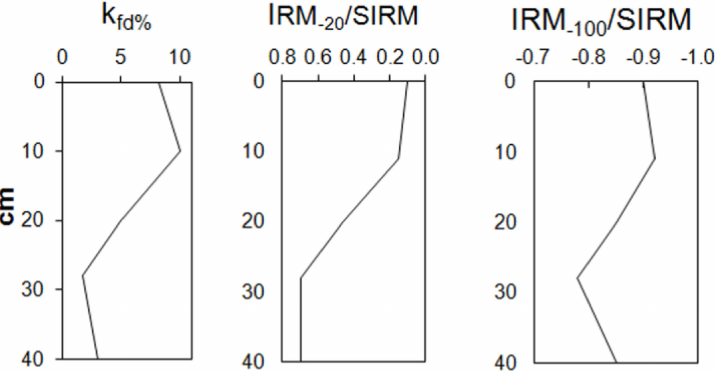
Figure 9. Indicative vertical distributions of k , and the interparametric ratios fd% IRM /IRM and IRM /IRM in a core obtained from the lower estuary − 20 mT 300 mT − 100 mT 300 mT of Louros River.